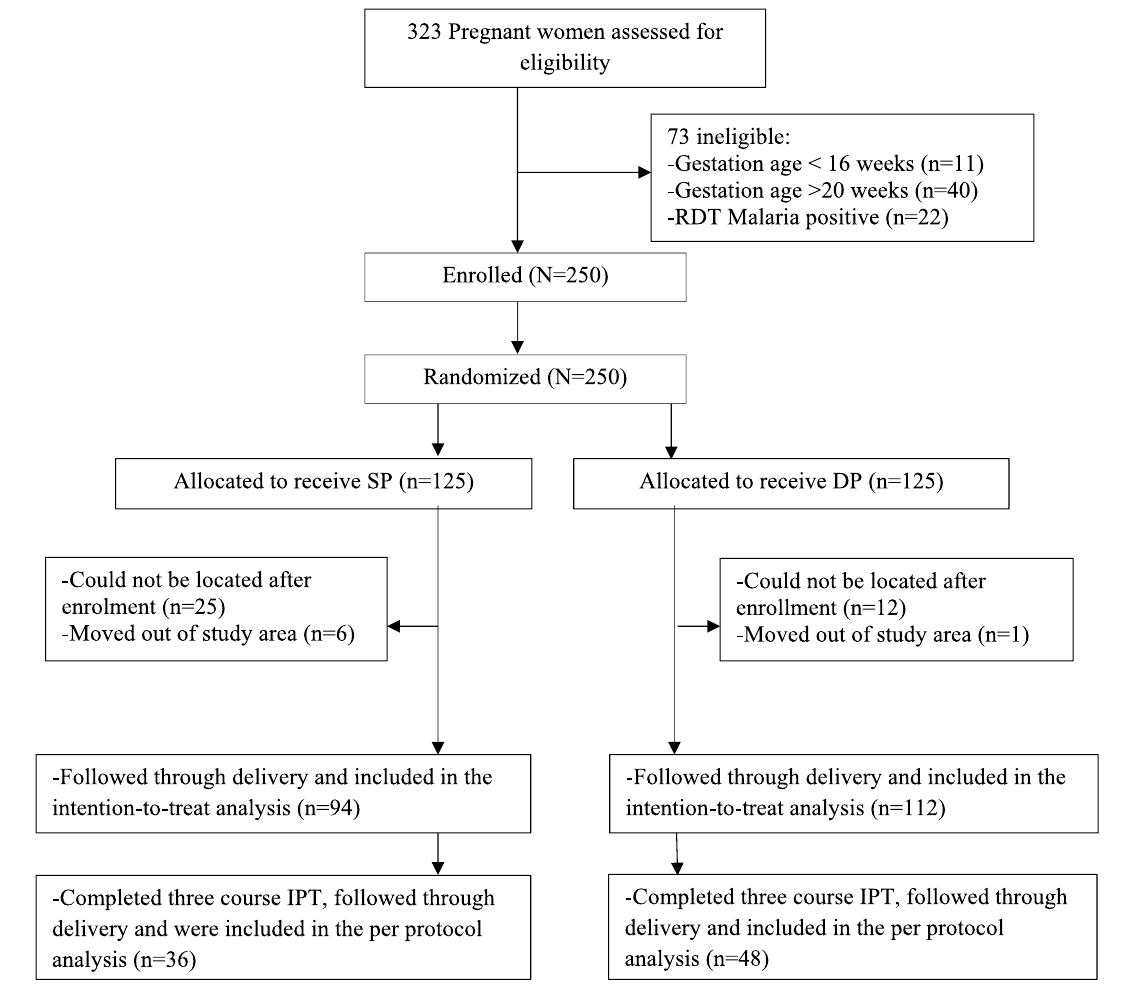
Fig. 1 CONSORT diagram of participant